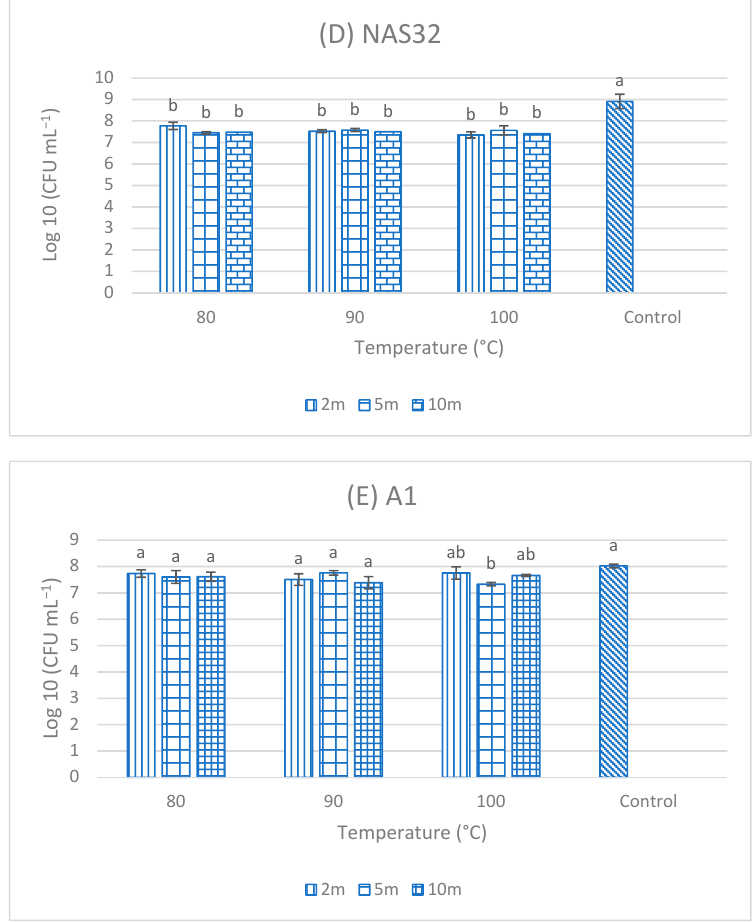
Figure 4. Resistance of ( A ) L11, Bacillus amyloliquefaciens ; ( B ) LAB3, Enterococcus hirae ; ( C ) SPS11, Lysinibacillus fusiformis ; ( D ) NAS32, Lysinibacillus sphaericus ; and ( E ) A1, Lysinibacillus fusiformis to high temperatures. Values are presented as mean ± SE ( n = 3). Significant differences are indicated by different letters ( p < 0.05).